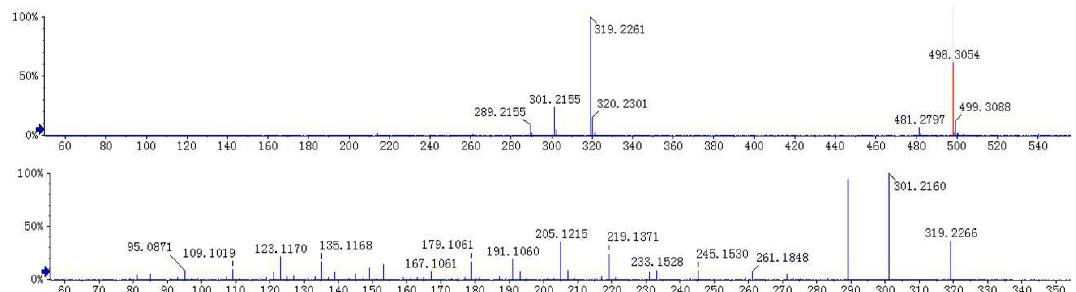
Figure 4. The proposed fragmentations pattern of andrographidine E ( 1 ).